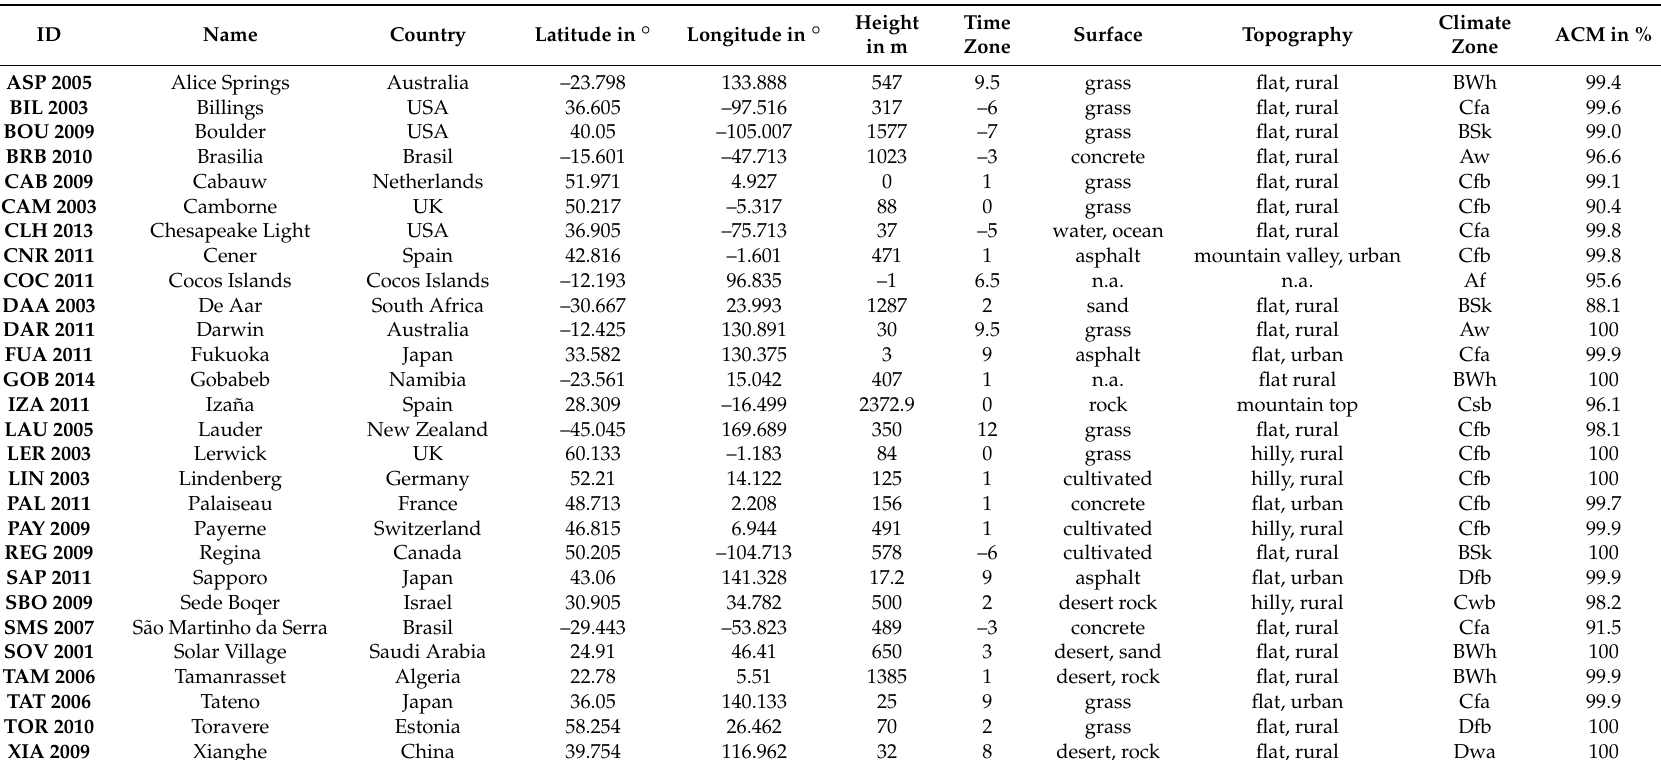
Table 2. Overview over the 28 datasets that were used in this work. The locations are spread over the globe between − 45 ◦ South and 52 ◦ North. Height above sea level, surface, topography and climate zones (according to Köppen [7]) show a high level of variation. The years of measurement were chosen to provide a high annual completeness of measurement (ACM), i.e., as few missing data points as possible. The total resulting amount of data points that is used in the following analysis exceeds 14.7 million (or approximately 7 million when omitting night